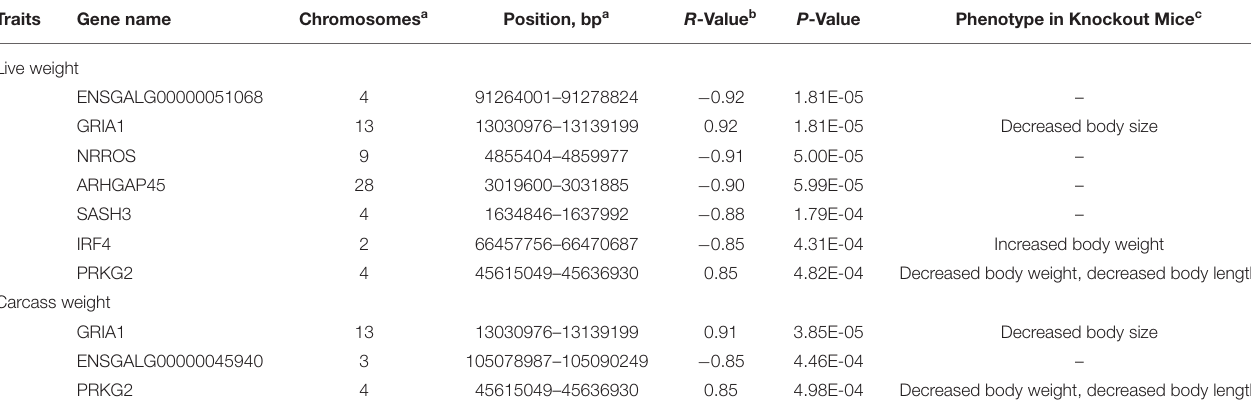
TABLE 2 | Candidate genes identified in pituitary gland for growth and carcass traits. Traits